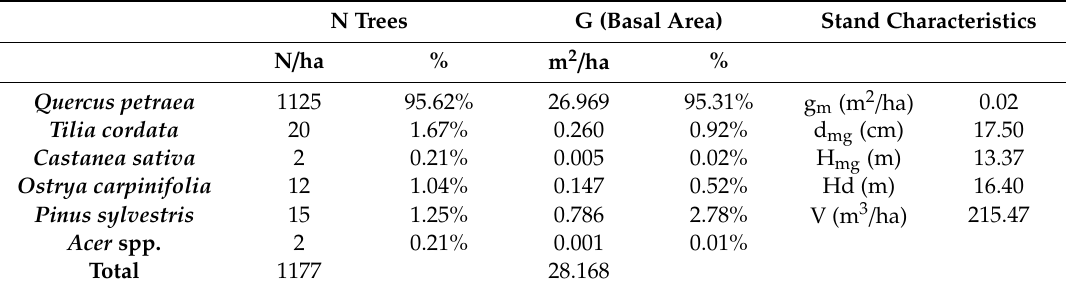
Table 3. Species mixture, total basal area and stand characteristics of the forest stand at the beginning of the experiment. Stand characteristics referred to sessile oak population only (g m : average basal area; d mg : diameter at average basal area; h mg : height at average basal area diameter; Hd: dominant height (average height of the tallest 100 trees); V: standing volume). N Trees G (Basal Area) Stand Characteristics N / ha % m 2 / ha Quercus petraea